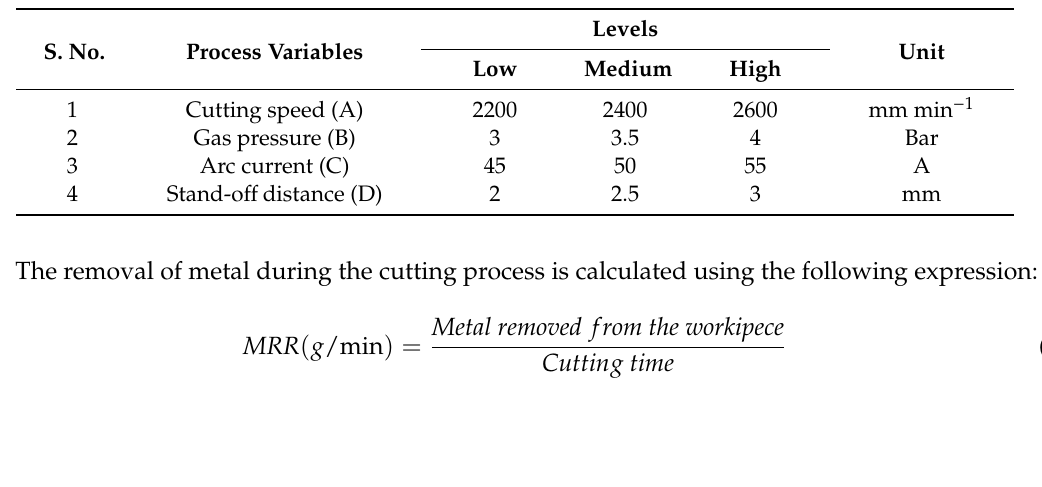
Table 1. Plasma arc cutting variables and their